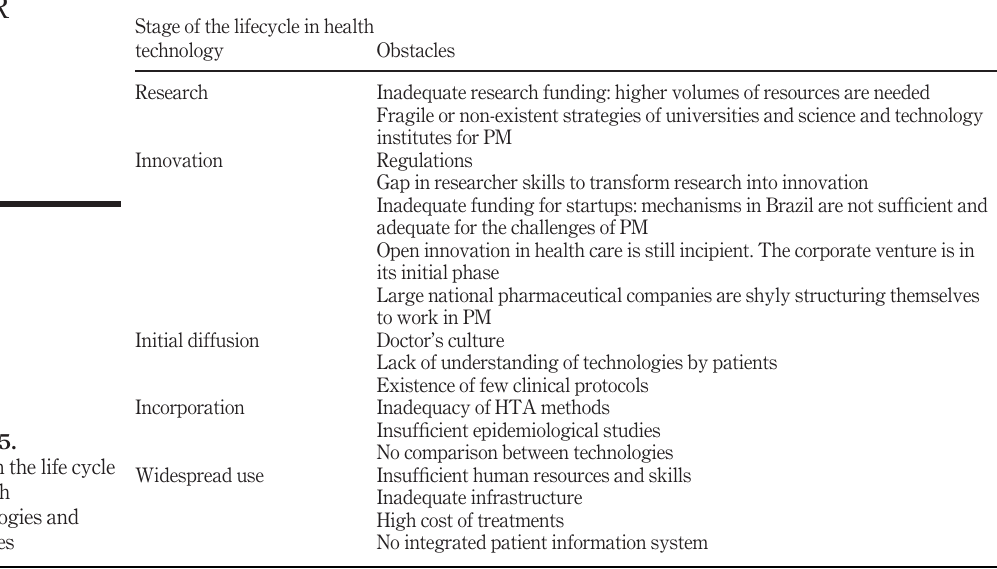
Table 5. Stage in the life cycle of health technologies and